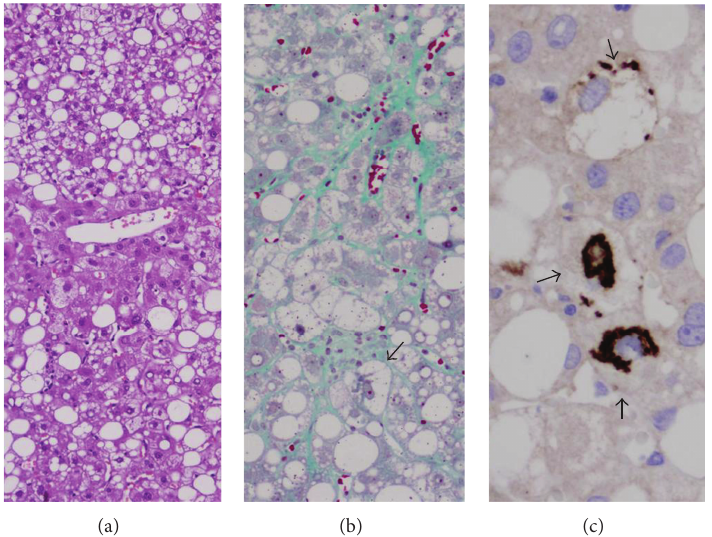
Figure1:Histologicalchangesinliverbiopsyfrompatientwithataxia-telangiectasia.Hepaticlobuleshowinghepatocyteswithmacrovesicular and multivesicular steatosis (hematoxylin-eosin (a)) and perisinusoidal and pericellular fibrosis around ballooning hepatocytes, some containing Mallory-Denk bodies (arrow) (Gomori trichrome (b)), which are more evident with immunohistochemical staining for p62 protein, arrows (c) (original magnification: × 10, × 20, and × 40,